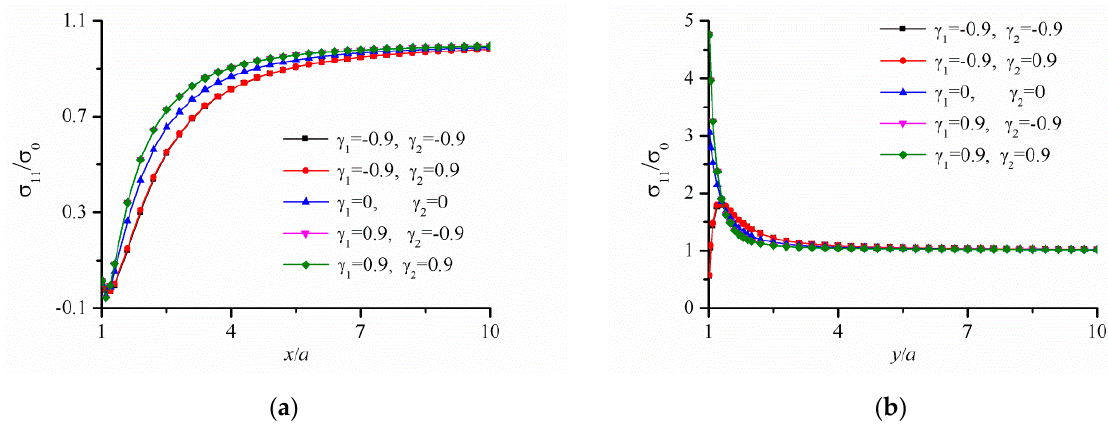
Figure 4. Variation of the ( a ) radial stress on the line y = 0, ( b ) the hoop stress on the line x = 0 in a uniform FGM panel with a circular hole under tension load along the x-direction.